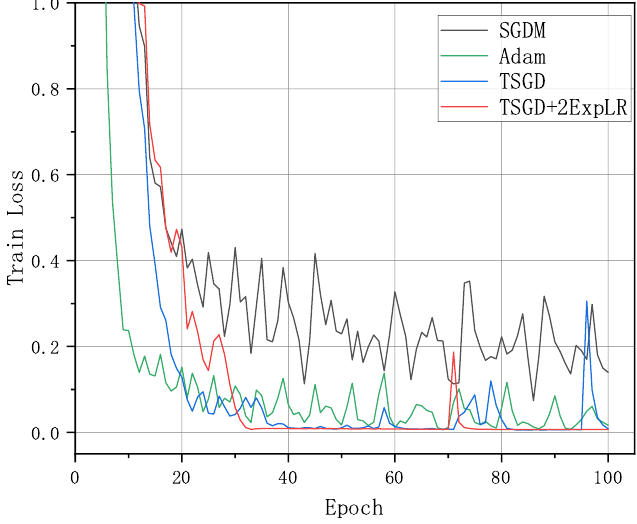
Figure 7. The loss of CASIA-FaceV5-ResNet18 on training